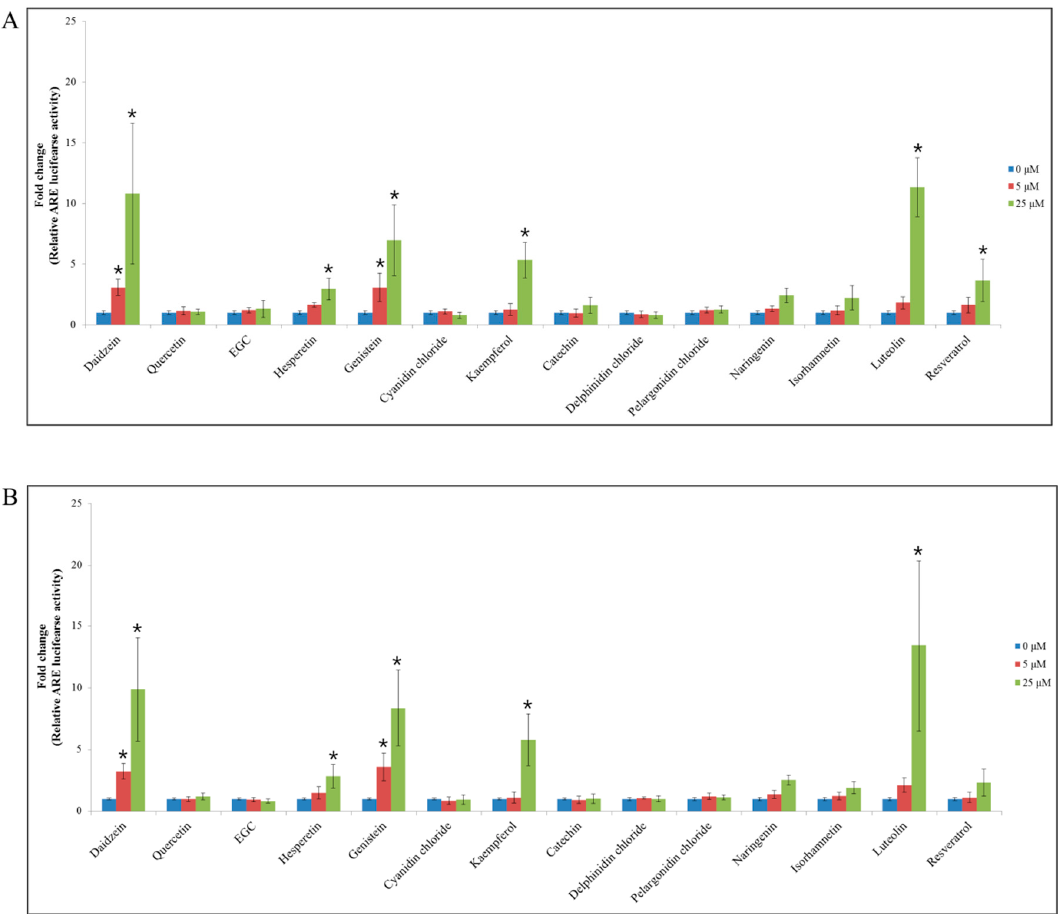
Figure 1. ARE-luciferase activity for 14 flavonoids in p53 +/+ and p53 -/- HCT116 cells. ARE-luciferase activity of 14 flavonoids at 5 or 25 μ M in p53 +/+ HCT116 cells ( A ) and p53 -/- HCT116 cells ( B ) after 24-h treatment. The ARE-luciferase activity was normalized to the total protein content. Data are expressed as mean ± SD of three independent experiments (*, a significant difference compared to the control group at p < 0.05).